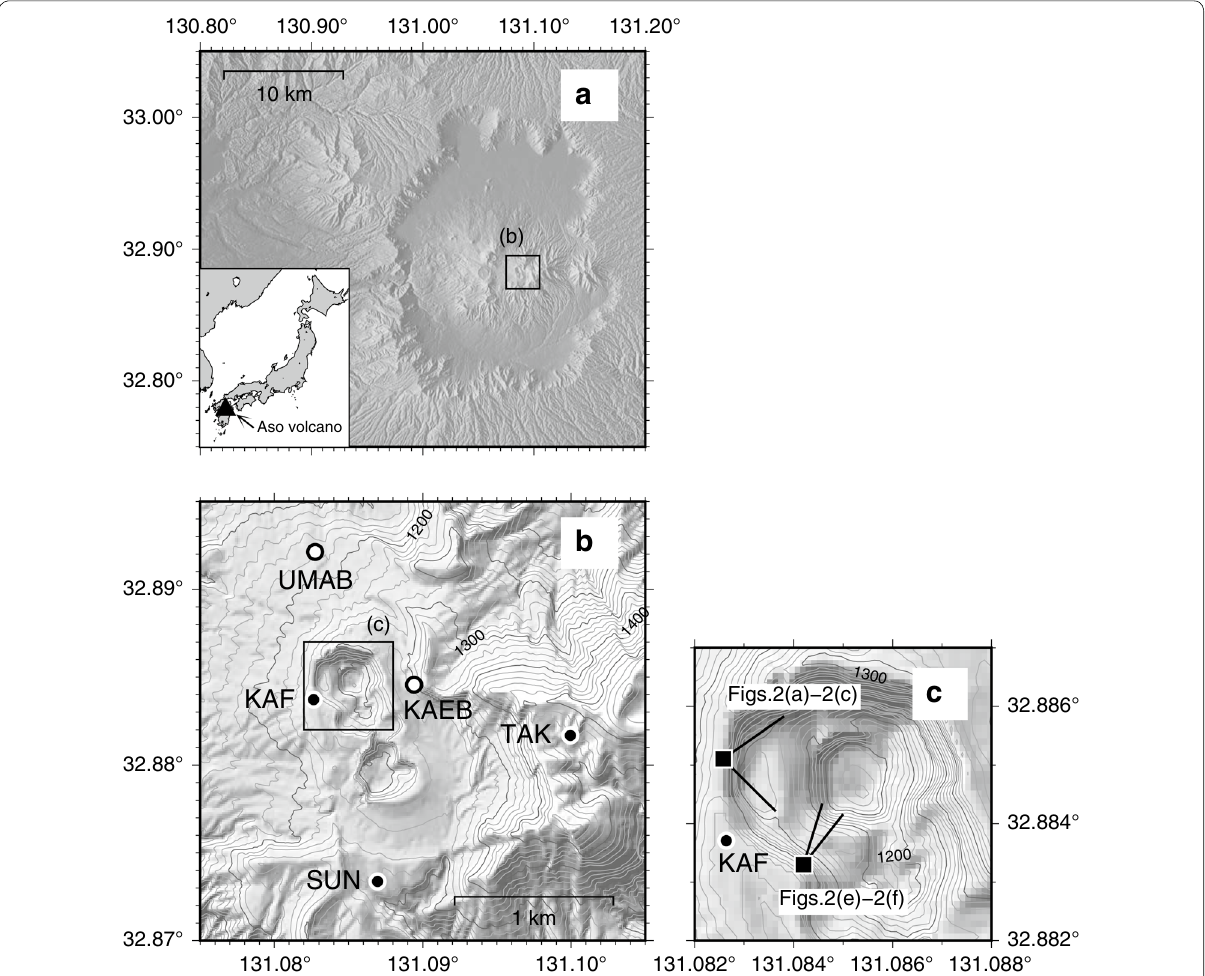
Fig. 1 Observation sites at Aso volcano, Japan. a Map of Aso volcano (Aso caldera) in Japan. b Five seismic stations around the active Nakadake crater of Aso volcano. Solid and open circles represent short-period and broadband seismometers, respectively. c Enlarged view around the active crater. The two black squares with fields-of-view indicate locations at which the photographs in Fig. 2 were